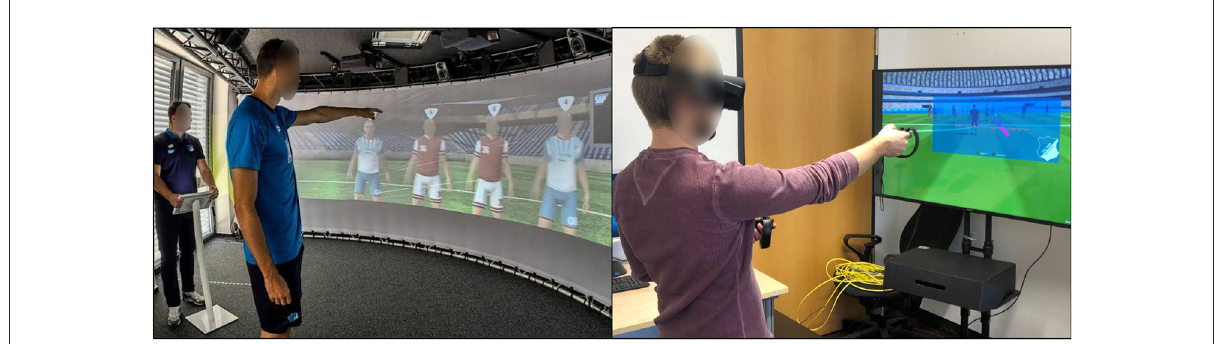
FIGURE1 The left part of the figure shows the original Helix for training of EFs on a 180 ◦ screen. It is a room-filling 180 ◦ screen (source: Michael Horeni, 2017). The right part of the figure shows the new CortexVR for VR-supported training of EFs with an Oculus Rift used by one of the authors.